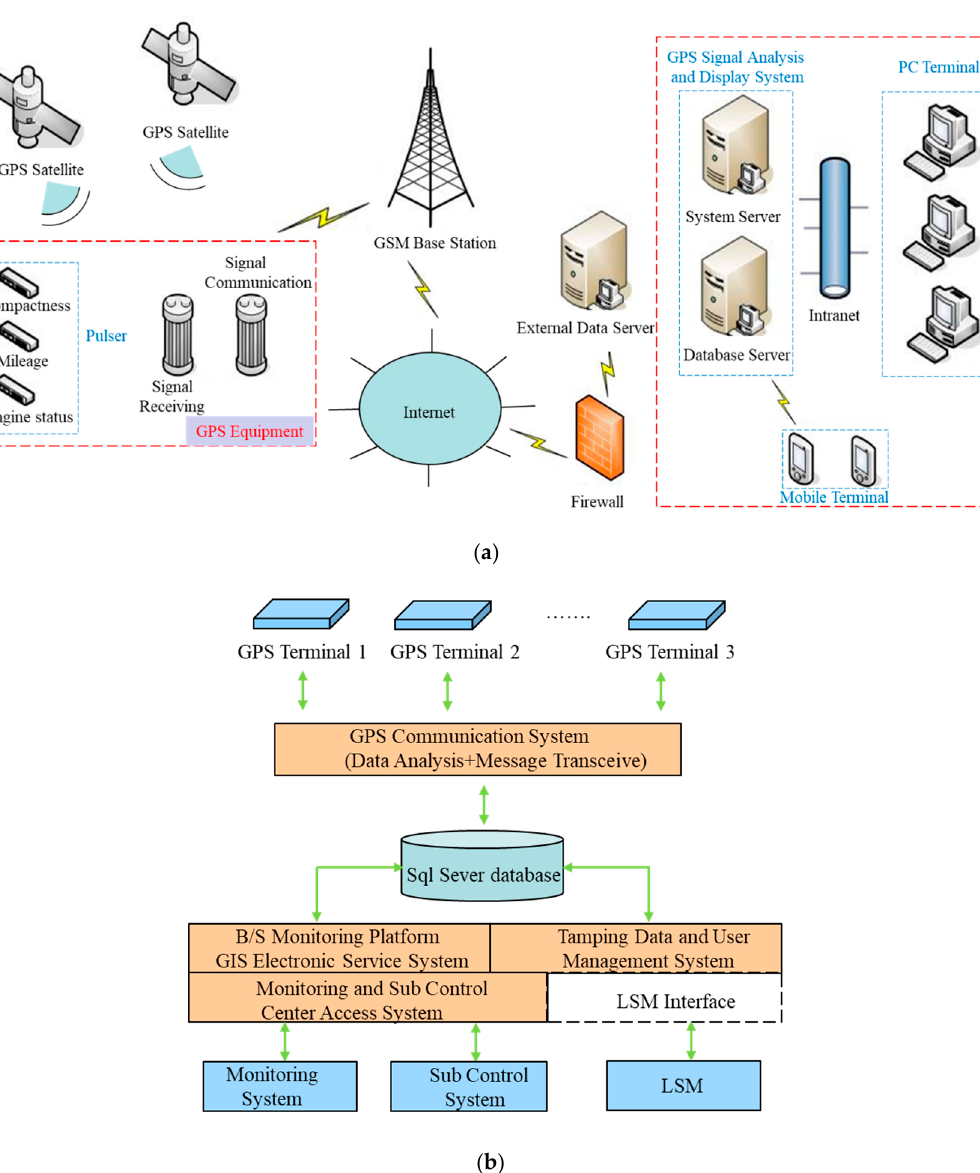
Figure 14. Remote real time monitoring system: ( a ) overall communication architecture; ( b ) server